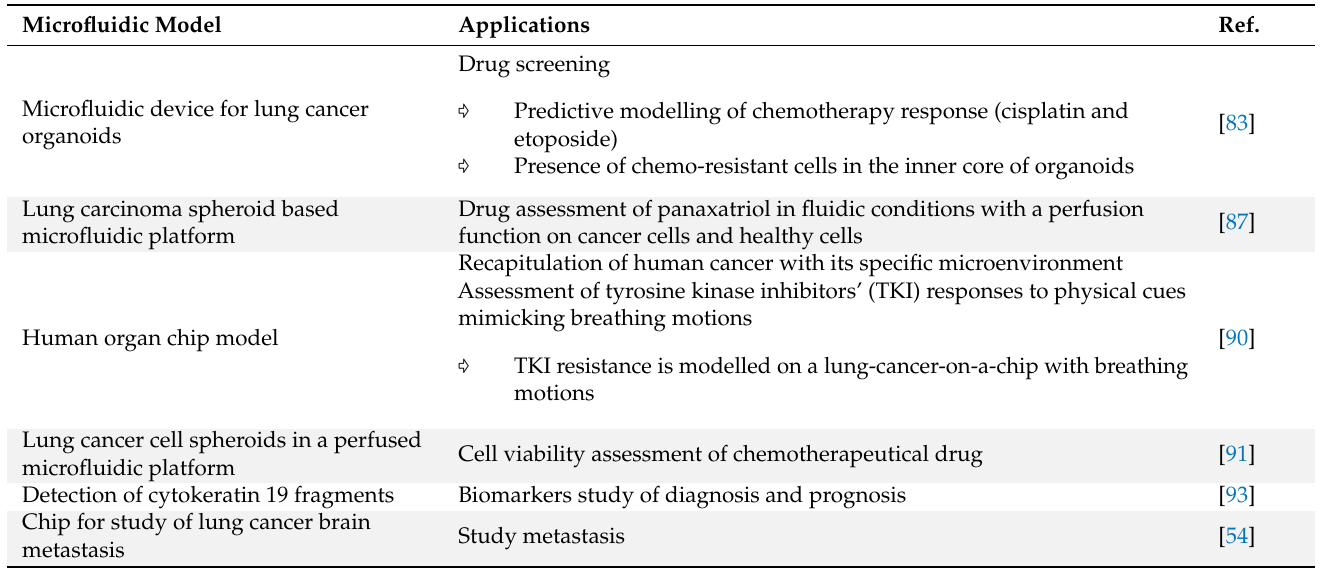
Table 4. Summary of integrative microfluidics systems in NSCLC.